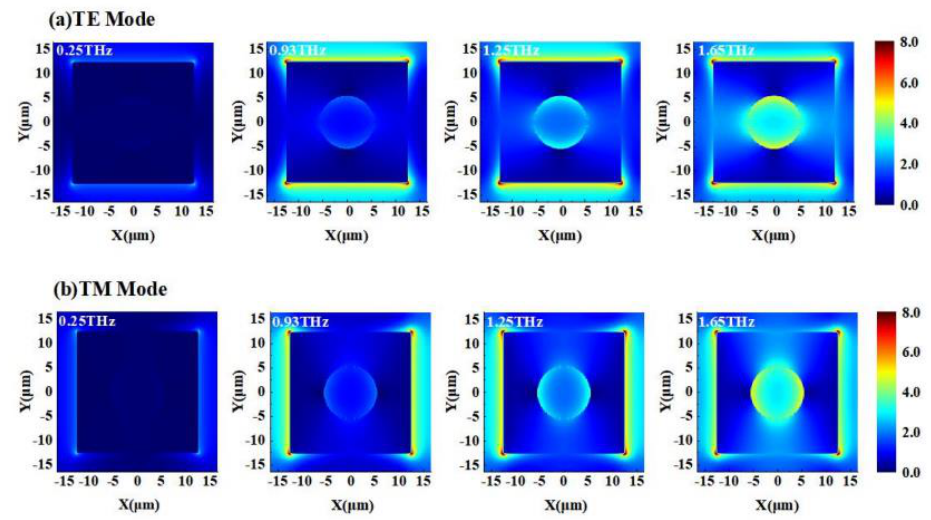
Figure 5. Distribution of electric-field. ( a ) TE mode; ( b ) TM mode.